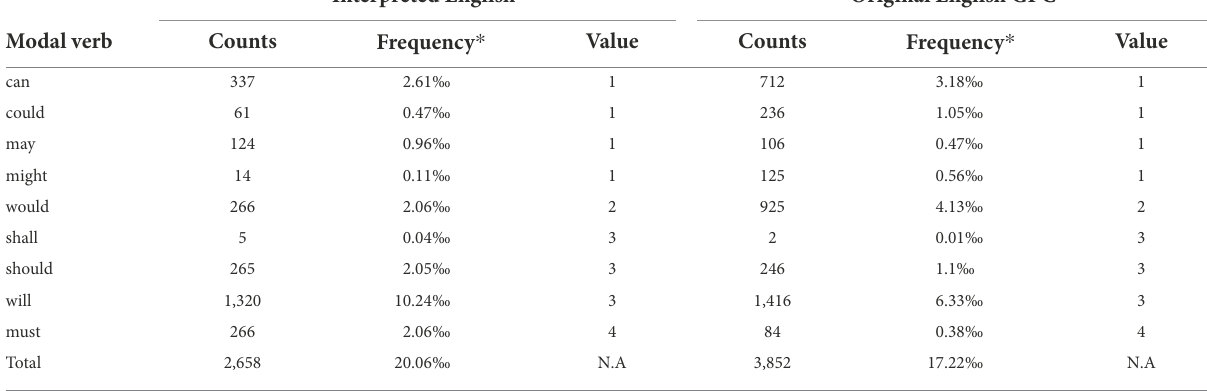
TABLE 6 Comparison of modal verbs in bilingual/English-speaking press conferences.